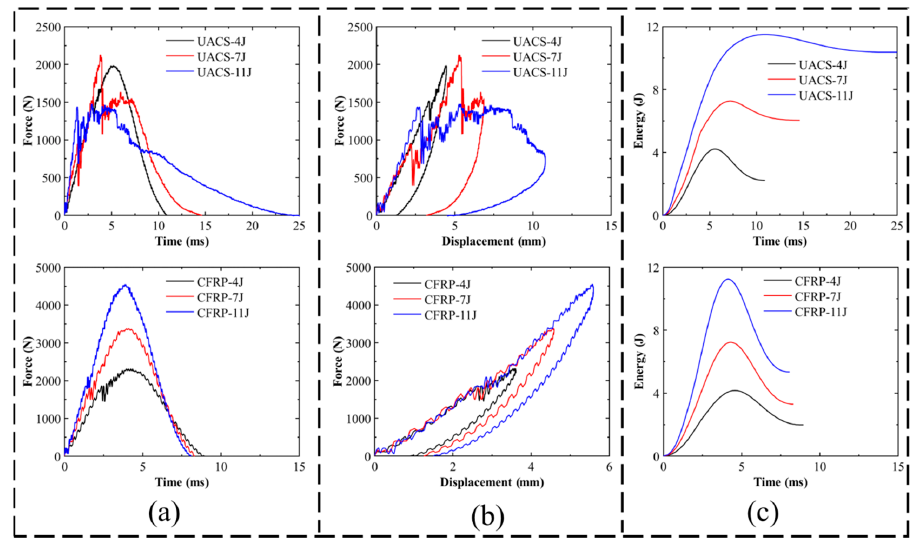
Figure 5. Comparison of experimental result of CFRP and UACS laminates under 4 J, 7 J and 11 J Table 3. Experimental values of different